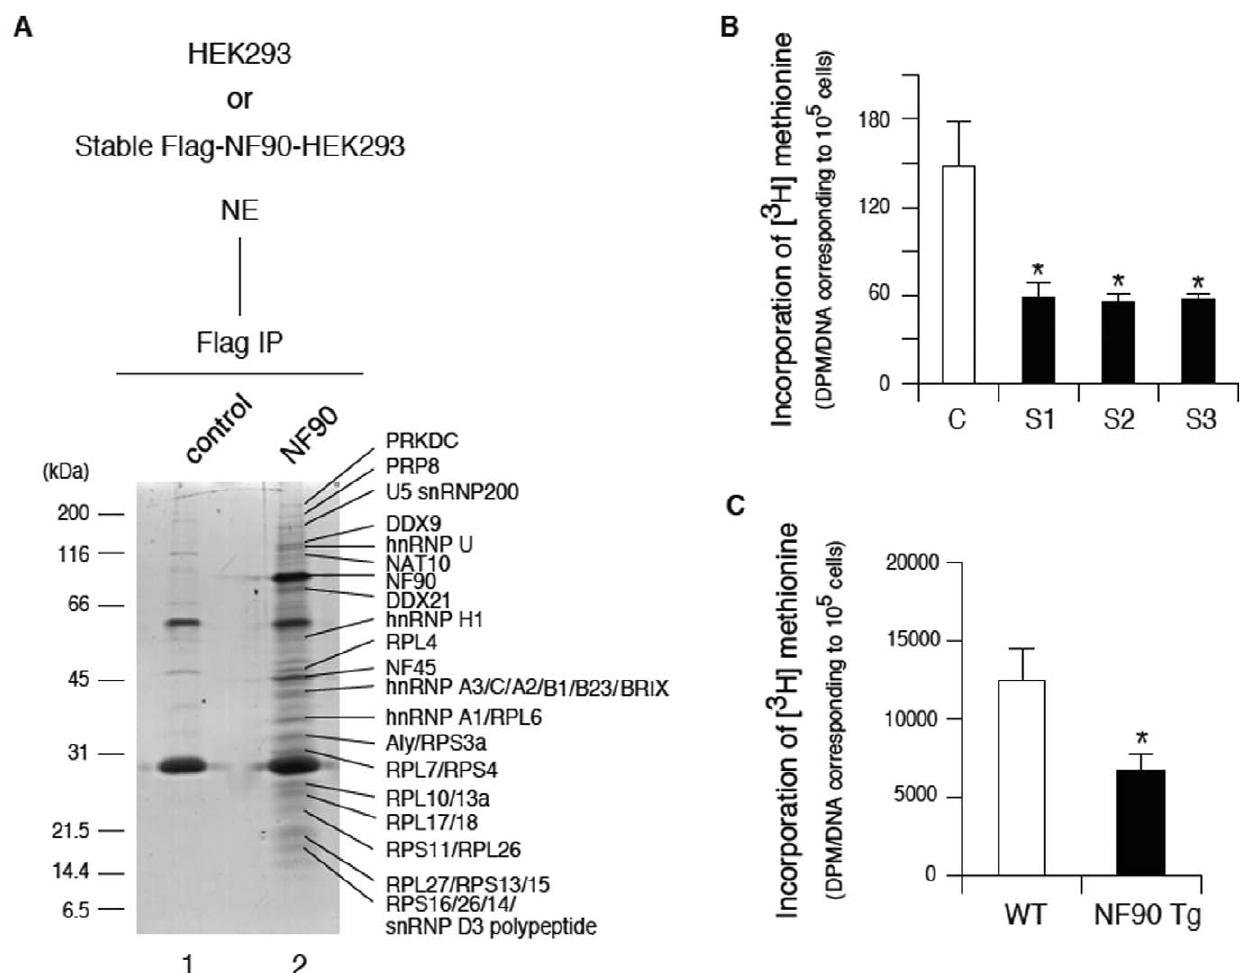
Figure 6. NF90 represses protein synthesis rate. (A) Isolation of NF90-associated complexes. The resulting peptide mass fingerprints were compared to those in a data base, and the identity of each protein is shown to the right of the gel. The molecular markers are indicated on the left in kilodaltons (kDa). (B and C) Protein synthesis rate in untransfected (C) and Flag-NF90-HEK 293 stable cells (S1, S2, and S3) (B) and primary cells of skeletal muscles from WT (n=2) and NF90 Tg mice (line TG1) (n=3) at 11 to 13 weeks of age (C). Protein synthesis was measured in cells incubated in medium containing [ 3 H]methionine. The DNA amounts in the cells used in this assay were quantitated by the DABA method for normalization of the data. Data are expressed as [ 3 H]methionine incorporated (DPM/DNA amount corresponding to 10 5 cells) and are expressed as means 6 SD of three independent experiments. *, p , 0.01 relative to control by a two-tailed Student’s t test.